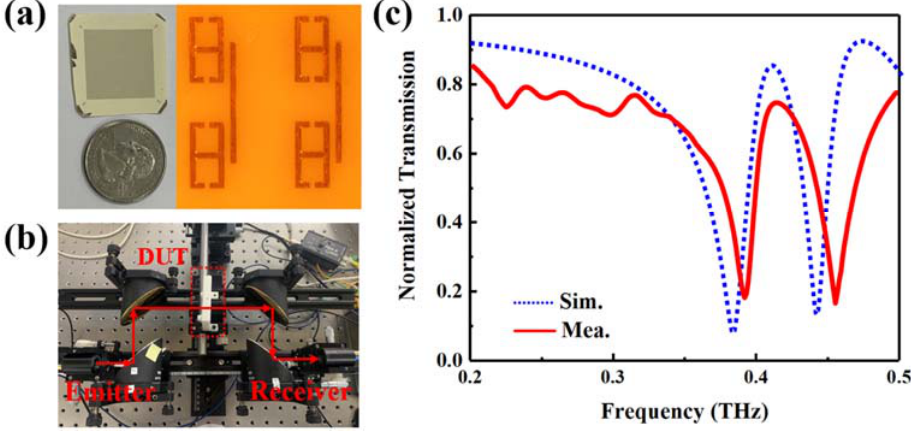
Figure 10. ( a ) Photograph and the enlarged view of the fabricated EIT MTM device. ( b ) Photograph of the test setup. ( c ) Measured (red solid line) and simulated (blue dotted line) transmission curves of the fabricated EIT MTM device.